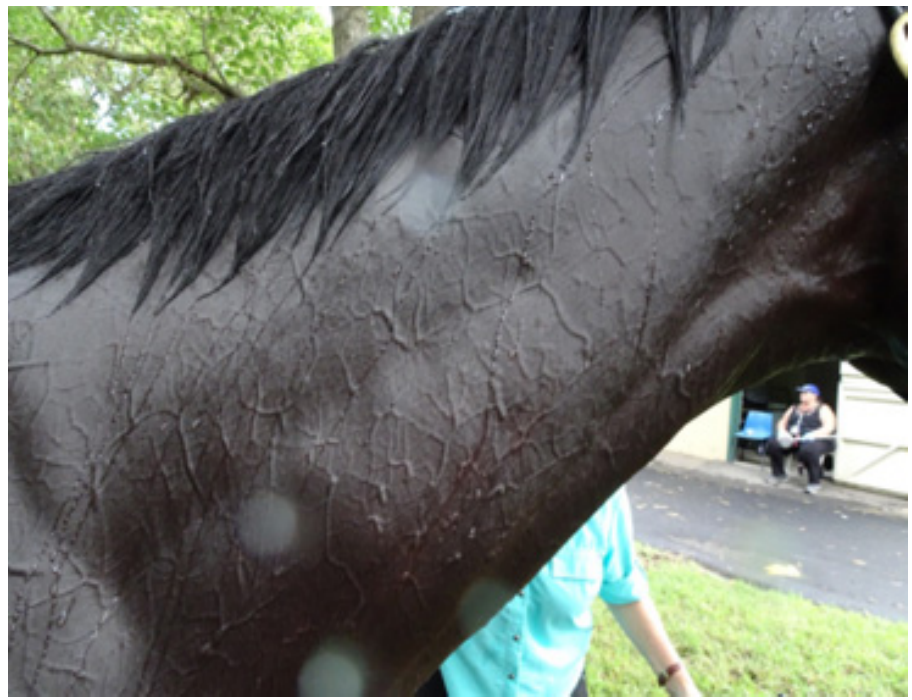
Figure 24. Horses should be cooled until their CNS dysfunction normalises, their skin vessels are just beginning to disappear, and their SST is decreasing.